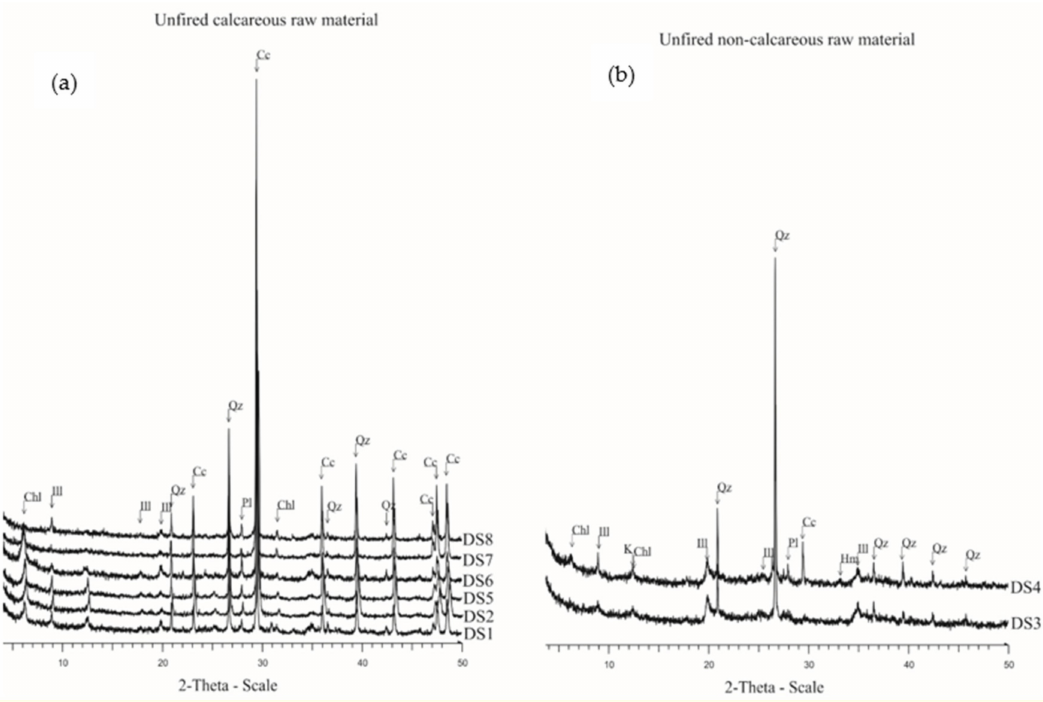
Figure 14. Composite graphs of the X-ray patterns ( a ) of the unfired calcareous raw materials and ( b ) of the non-calcareous raw material. Abbreviations: Qz = quartz, Cc = calcite, Pl = plagioclase, Ill = illite, Chl = chlorite, Hm = hematite.